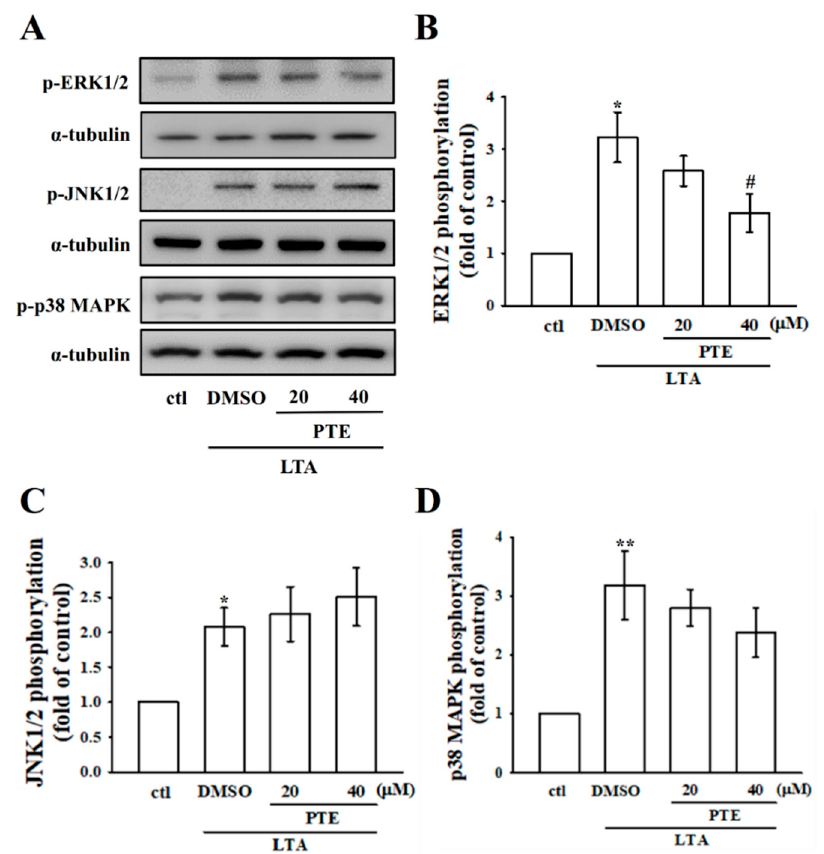
Figure 3. Effects of PTE on LTA-induced mitogen-activated protein kinases (MAPKs) phosphorylation in RAW cells ( A–D ). Cells were treated with 0.1% DMSO or PTE (20 and 40 µM) for 30 min, followed by LTA (5 µg/mL) for 1 h. PTE diminished the LTA-induced phosphorylation of ERK ( B ) , but it did not have an effect on JNK ( C ), and p38 MAPK ( D ) phosphorylation. Data expressed are the means ± S.E.M. ( n = 4); * p < 0.05, and ** p < 0.01 vs. control cells; # p < 0.05 vs. PTE pretreated cells.